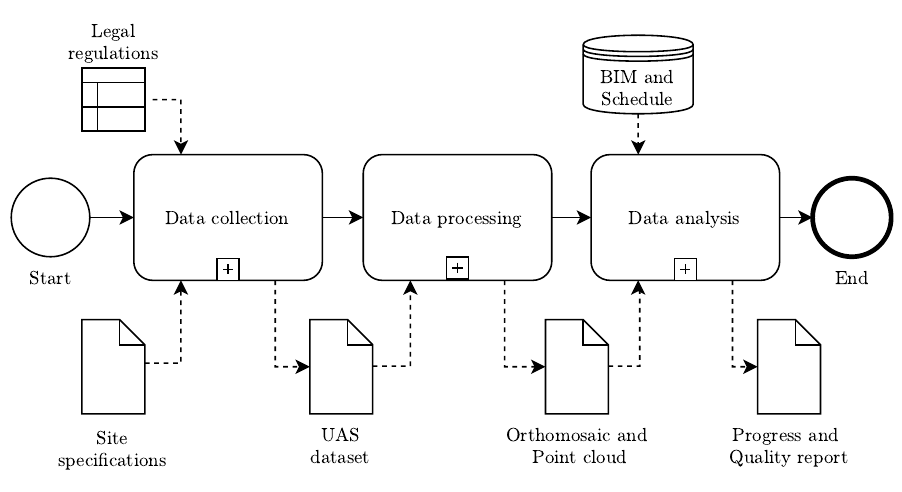
Figure 1. General process.